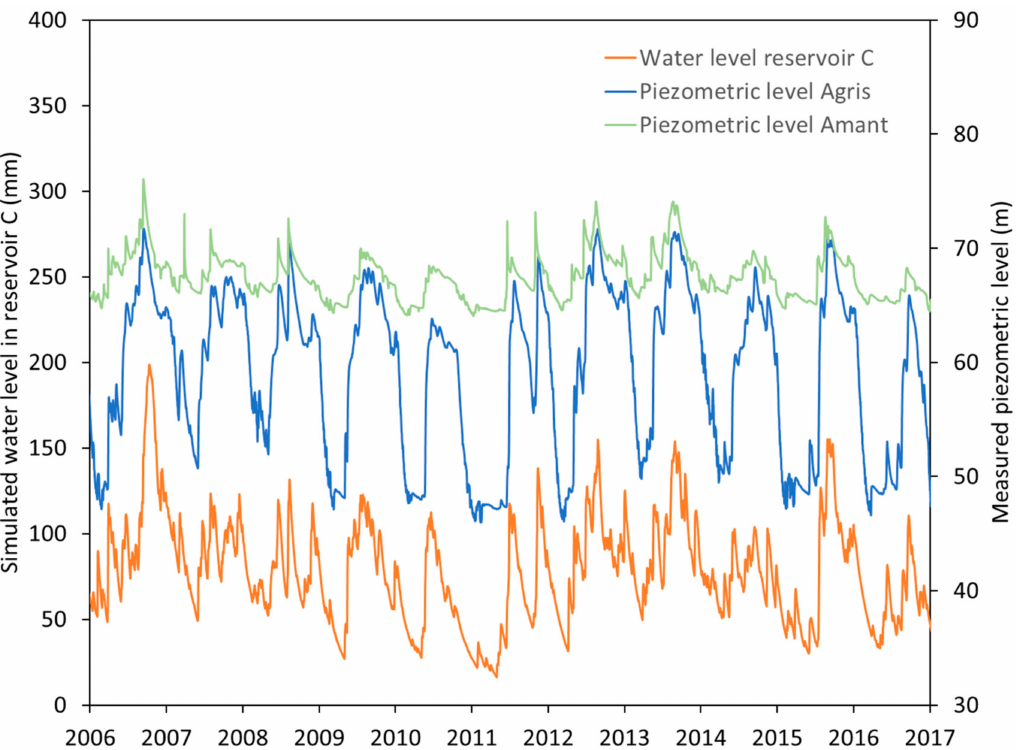
Figure 4. Comparison between the water level in reservoir C and the piezometric level observed at Agris and Amant station.